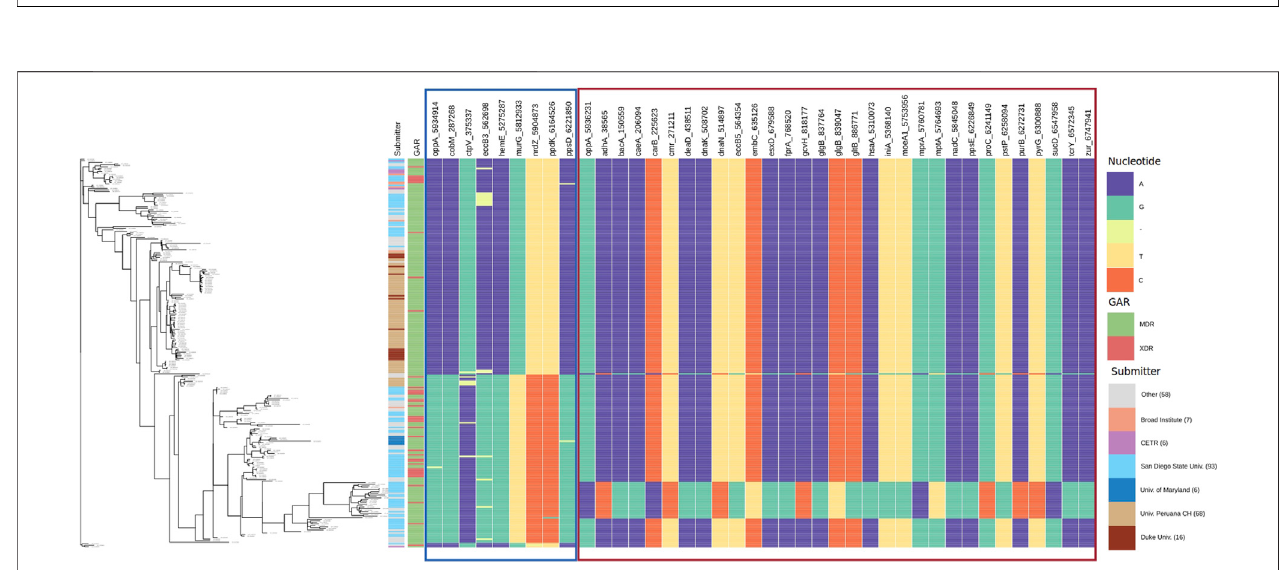
FIGURE7| Alleledistributionatthelociofgenesinteractingwith oppA .Labelsofthecolumnindicategenenameandlocus.Estimatedphylogenyisincludedonthe left. Interacting loci are organized in sections with borders. The border color corresponds to the color of the sections in Supplementary Data S8 . GAR = Genotypic Antibiotic